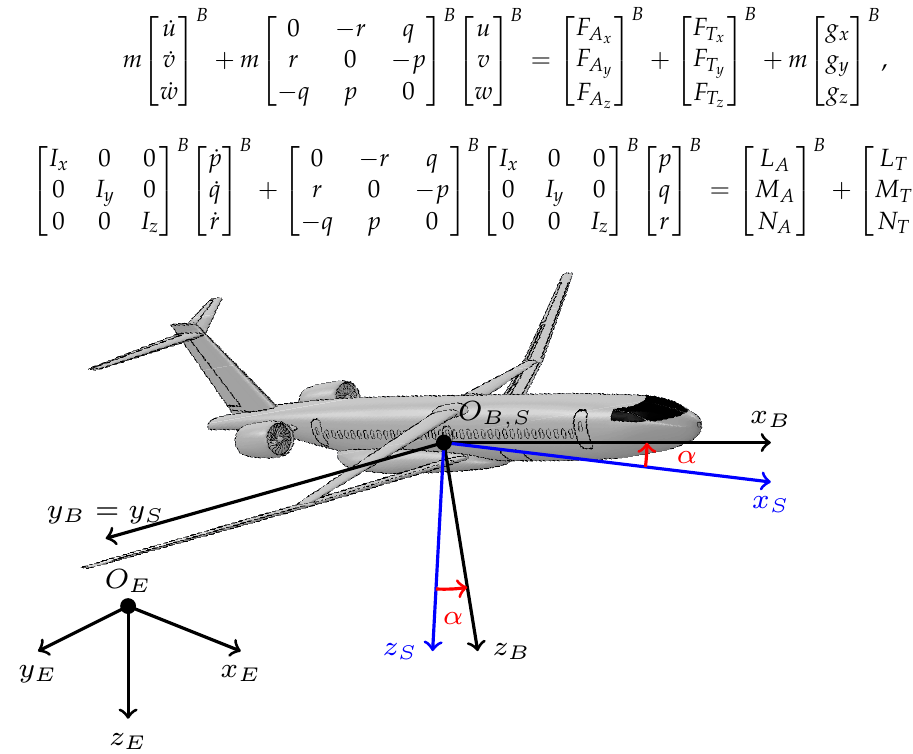
Figure 2. Chaka-50 body, stability, and inertial frames of